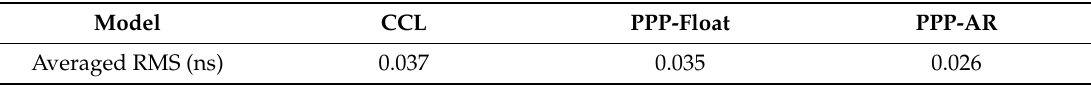
Table 7. Averaged RMS of satellite DCBs compared with CODE final monthly satellite DCB products for DOY 100 to 106, 2017.